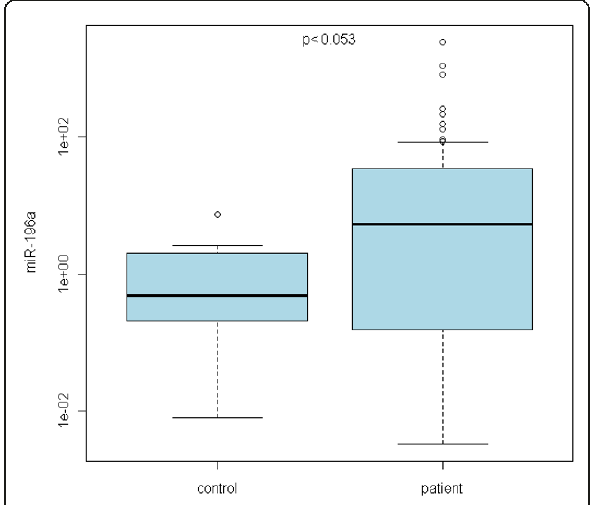
Figure 3 miRNA-196a upregulation in BE patients is statistically significant